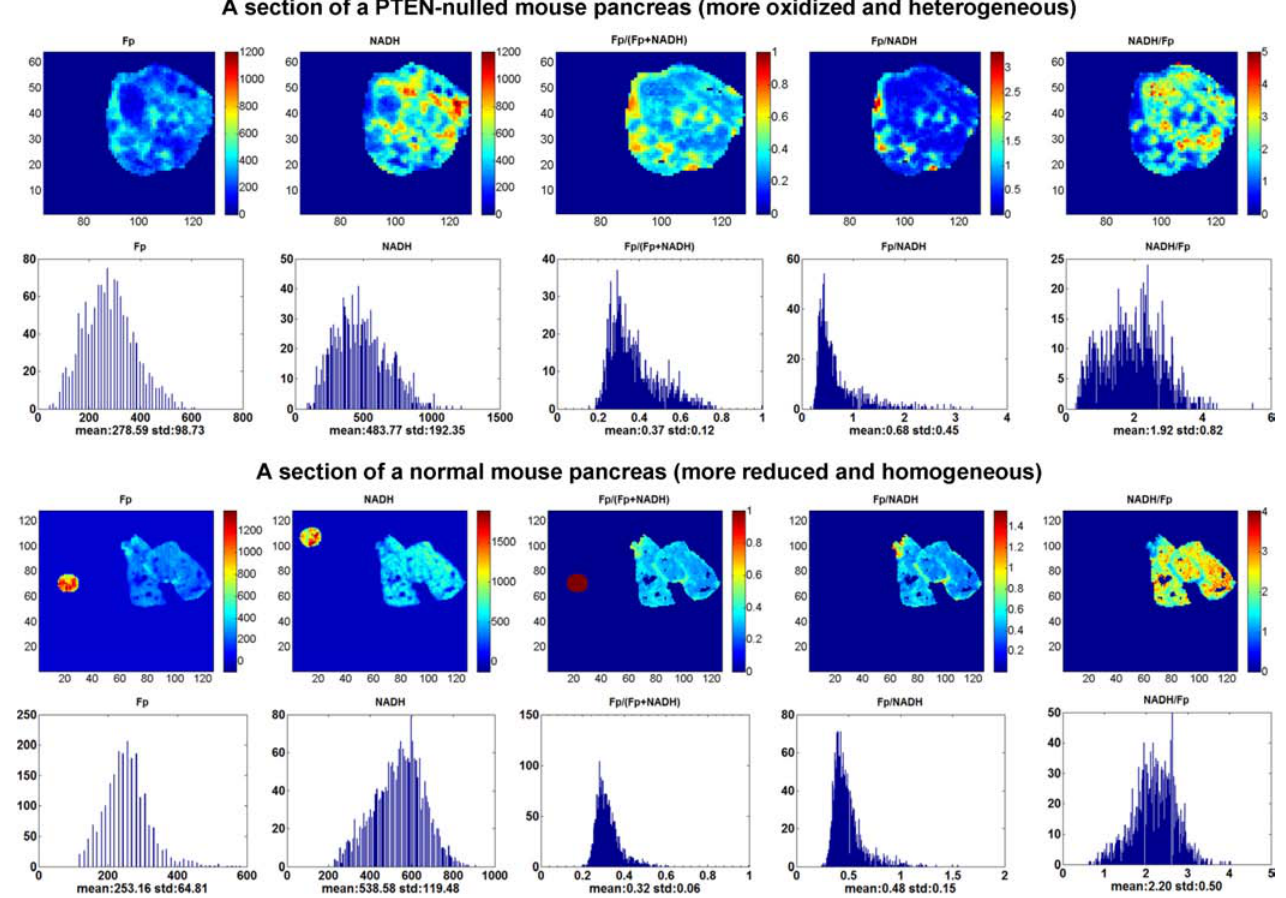
Fig. 8. The typical redox images and their corresponding histograms of the PTEN-null pancreas (top two rows) and the normal counterparts (bottom two rows). The ¯gure is reproduced with permission from Ref.